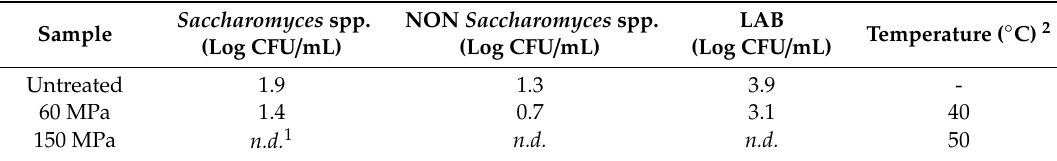
Table 3. Application of HPH (60 and 150 MPa) on fresh lees; e ff ect on yeast and LAB populations. Extracted from Carrano, 2016—Modified